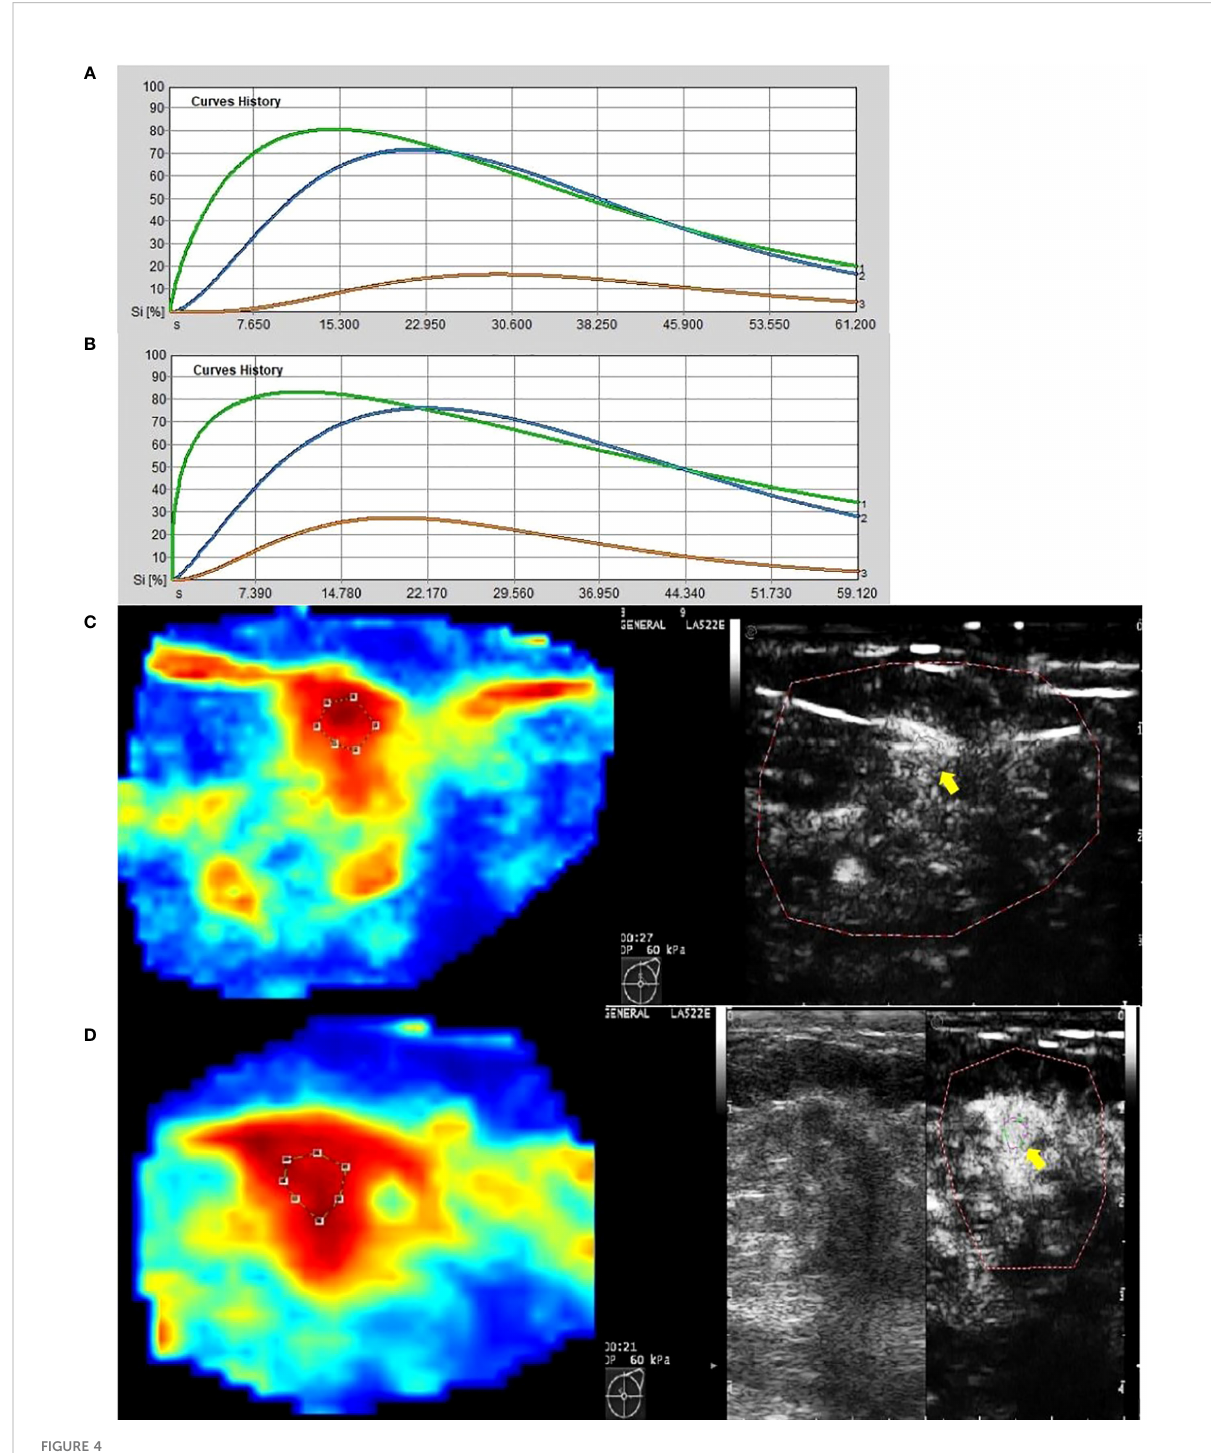
FIGURE 4 Images from a patient of non-response to NAC. (A) At baseline before NAC, contrast-enhanced ultrasound imaging showed a time-intensity curve generated according to regions of interest. The green line represents ROI 1 (the greatest enhancement area in central region of tumor), the blue line represents ROI 2 (the greatest enhancement area in edge of tumor), the yellow line represents normal breast tissue. (B) After the fi rst cycle of NAC, neither ROI 1 nor ROI 2 declined signi fi cantly. (C) At baseline before NAC, the circle represents ROI 1, and the red area means rich blood supply; the right image was gray-scale which correspond to the left one, and the yellow arrow referred to ROI 1. (D) After the fi rst cycle of NAC, the circle represents ROI 1, and the red area expanded, instead of shrunk; the right image was gray-scale which correspond to the left one, and the yellow arrow referred to ROI